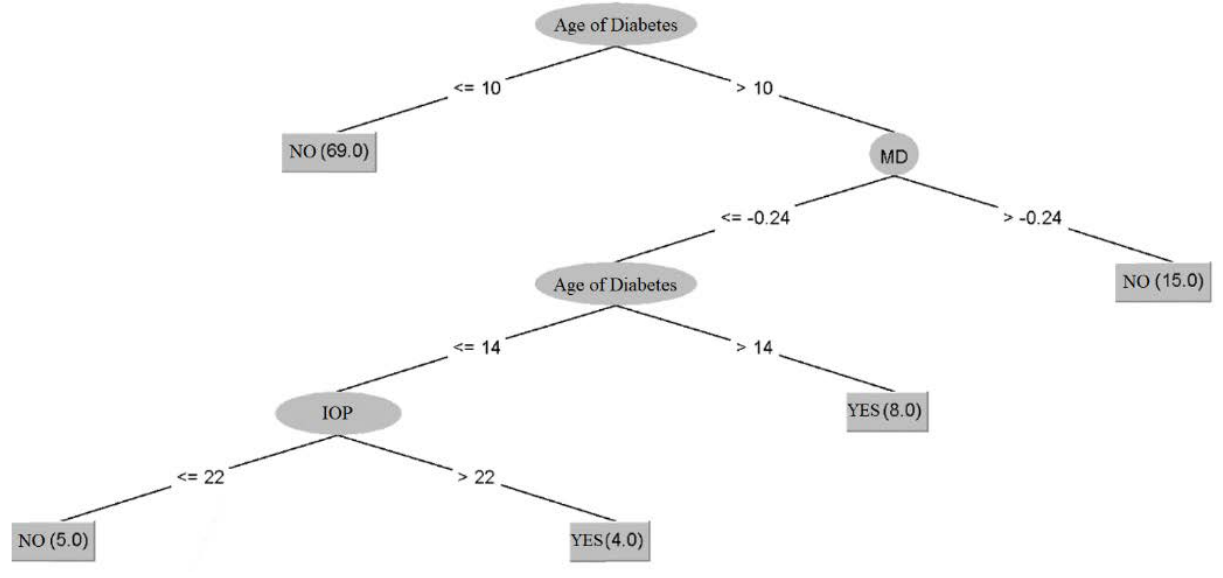
Figure 6. Results of C4.5 algorithm to predict diabetic retinopathy.